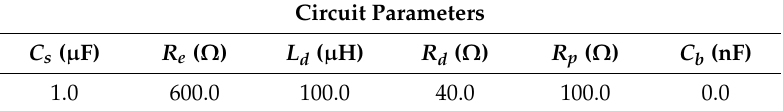
Figure 18. Equivalent circuit of the completed test system for the lightning impulse test of the power transformer winding. Table 5. Selected circuit parameters of the lightning impulse voltage generation circuit.